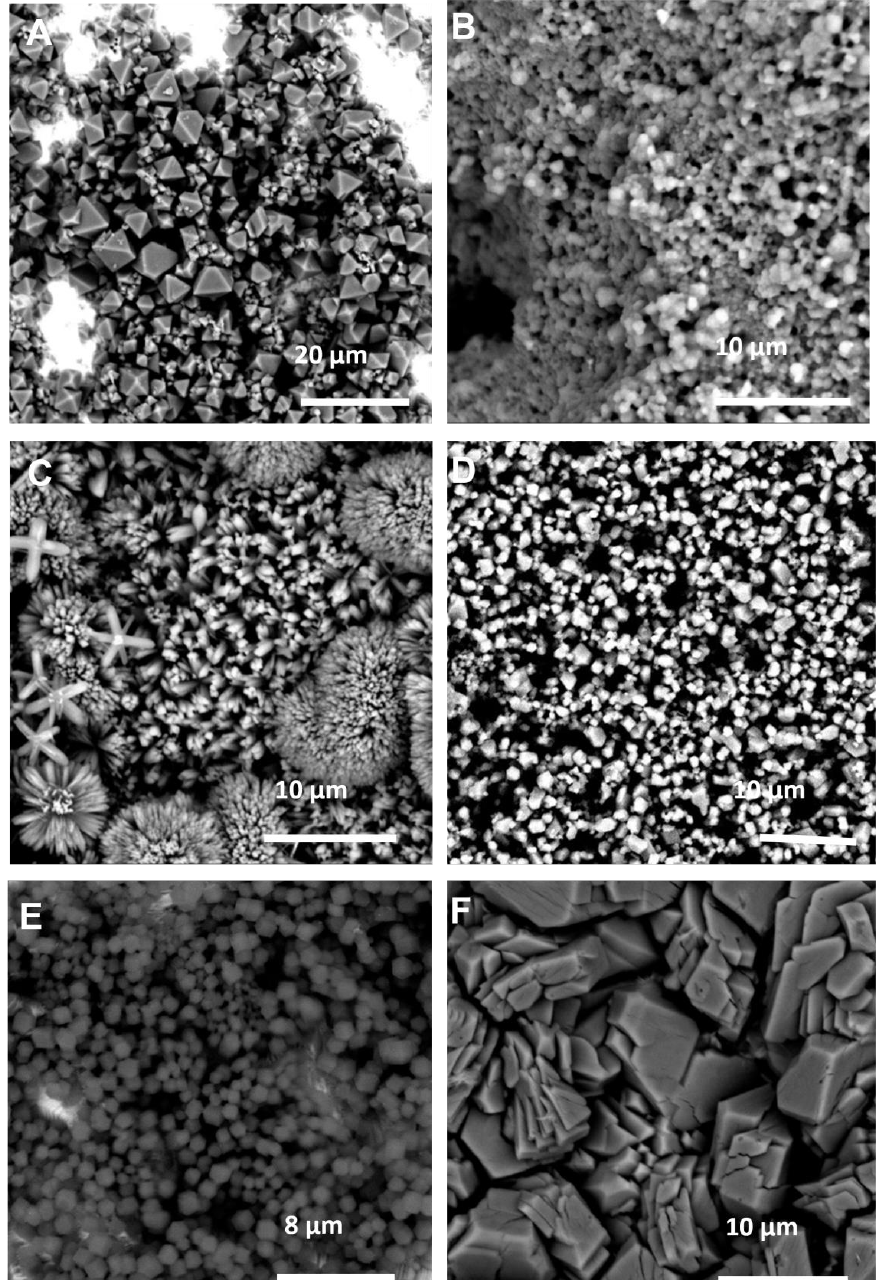
Figure 4. SEM images of the MOF coatings using GVL as the solvent for: ( A ) Cu and BTC; ( B ) Zn and mIM; ( C ) Zn and bIM; ( D ) Co and mIM; ( E ) Zn and eIM; ( F ) Zn and